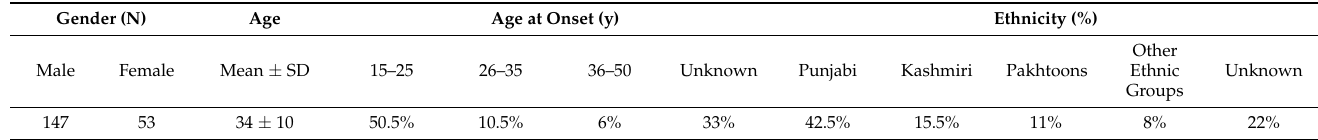
Table 1. Summary of all sociodemographic parameters studied for schizophrenia